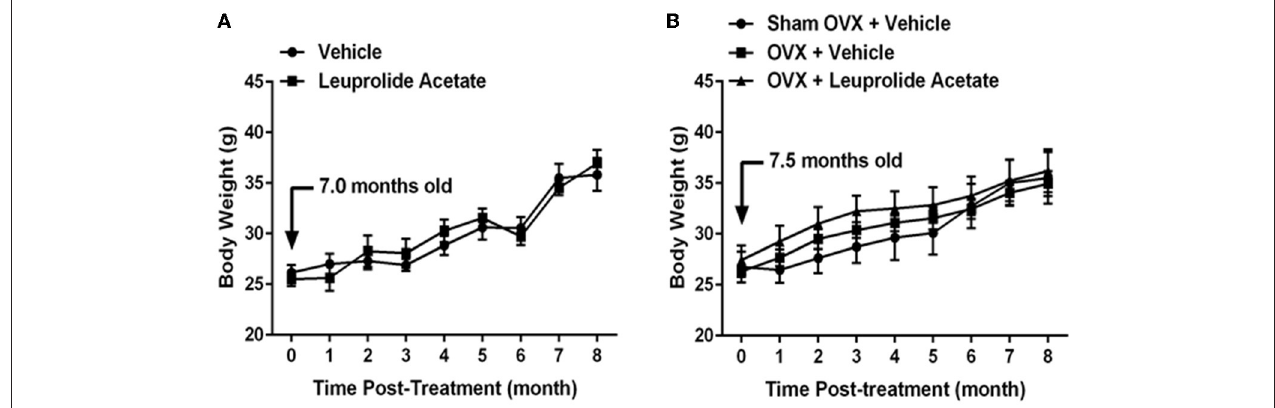
FIGURE 1 | Changes in body weight with aging in ovariectomized and leuprolide acetate treated mice. (A) Female C57B6JL mice at the age of 7.5 months were treated either with vehicle (saline) or leuprolide acetate (1.5 mg/kg) monthly for 9 months and body weights determined each month. (B) C57B6JL mice at the age of